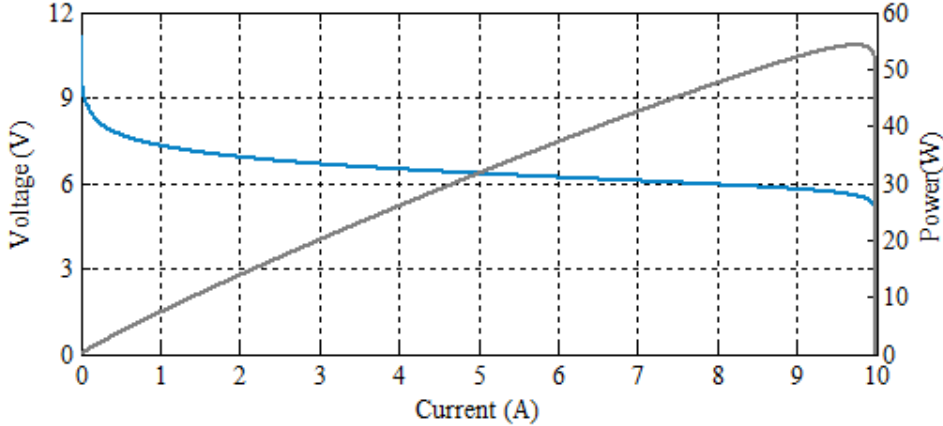
Figure 3. PEMFC 10 stack V-I and proportional–integral (PI) characteristics.